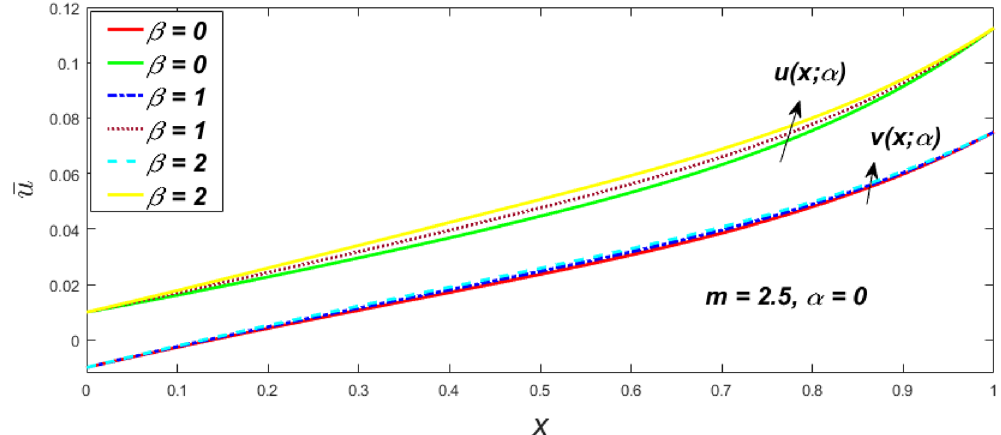
Figure 7. Fuzzy velocity profiles for the impact of β .